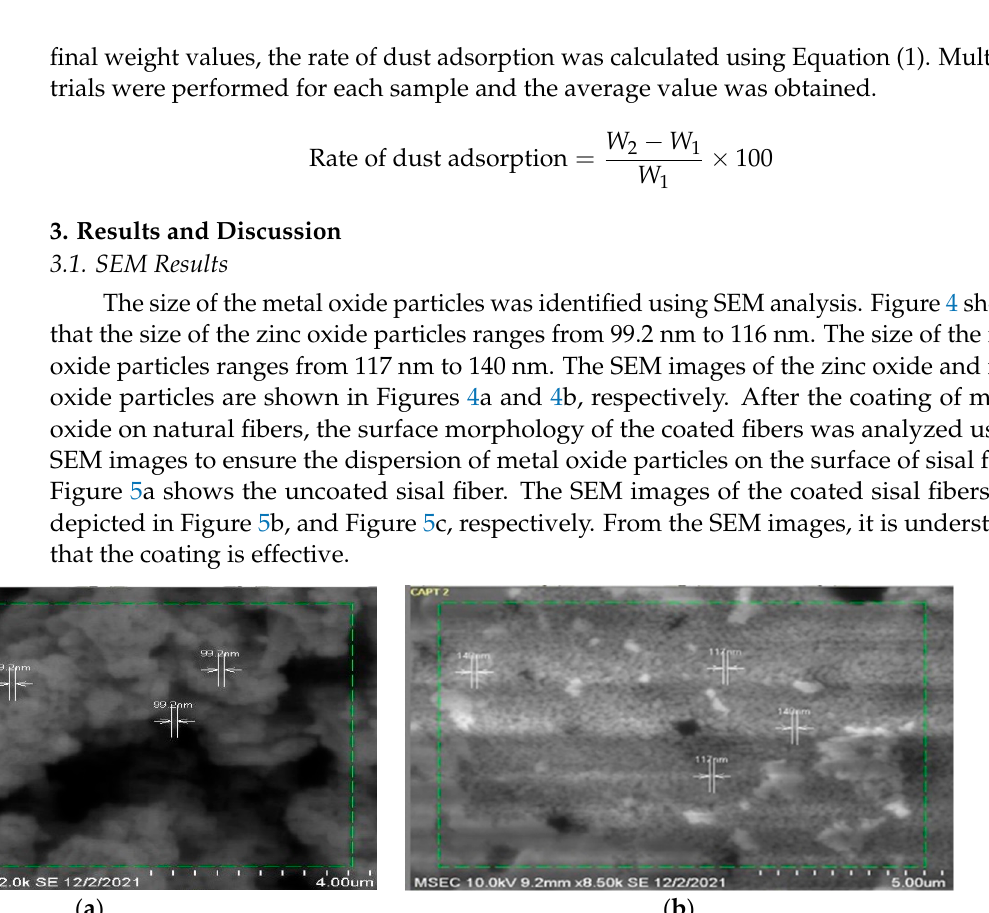
Figure 3. Zinc oxide-coated sisal fiber-based filter media.